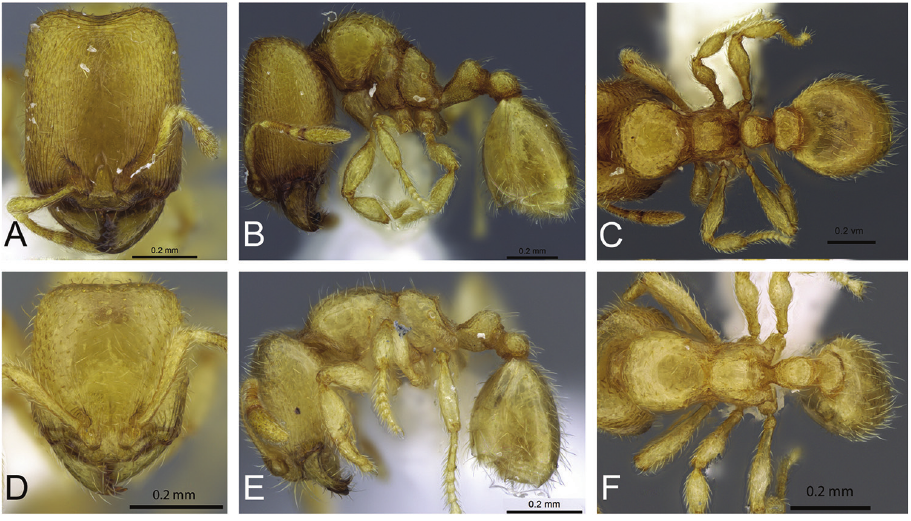
Figure 64. Carebara tana –holotype. Major worker, CASENT0437707: A head in full-face view B body in profile view C body in dorsal view. Minor worker, CASENT0438084: D head in full-face view E body in profile view F body in dorsal